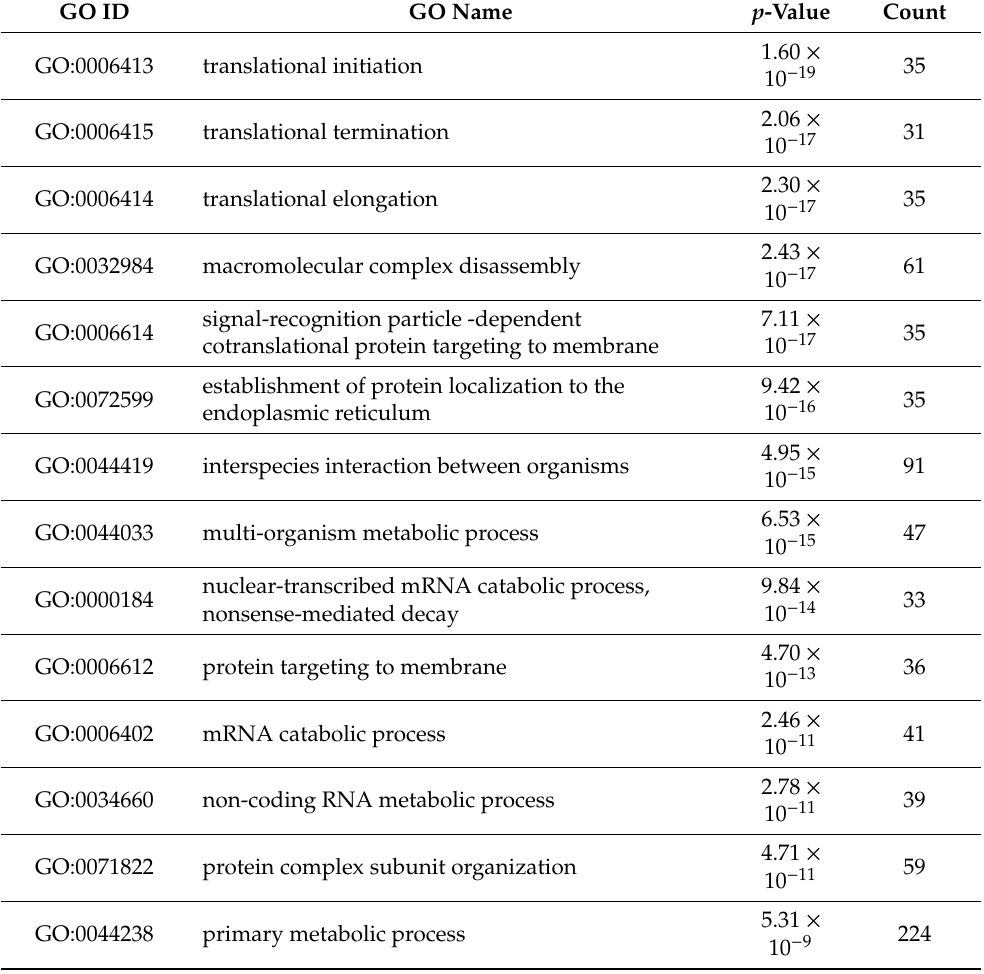
Table 1. Gene Ontology (biological process) analysis of up-regulated genes after Prospero homeobox 1 (PROX1) silencing in CGTH-W-1